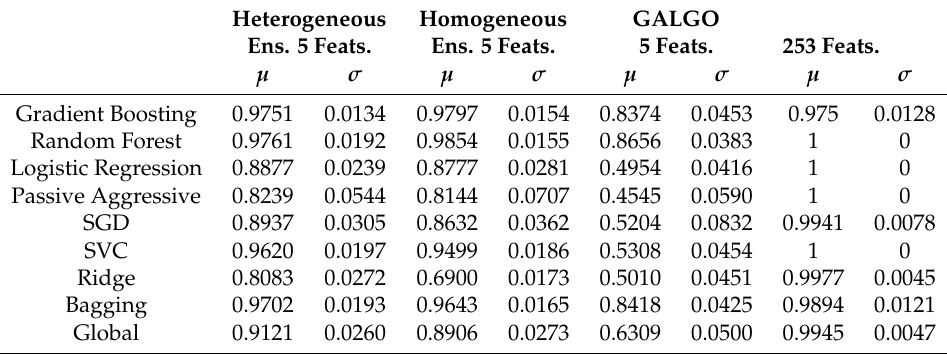
Table 2. Comparison of the results of the different feature selection algorithms, reduced from the initial 253 to 5 features to differentiate cancer